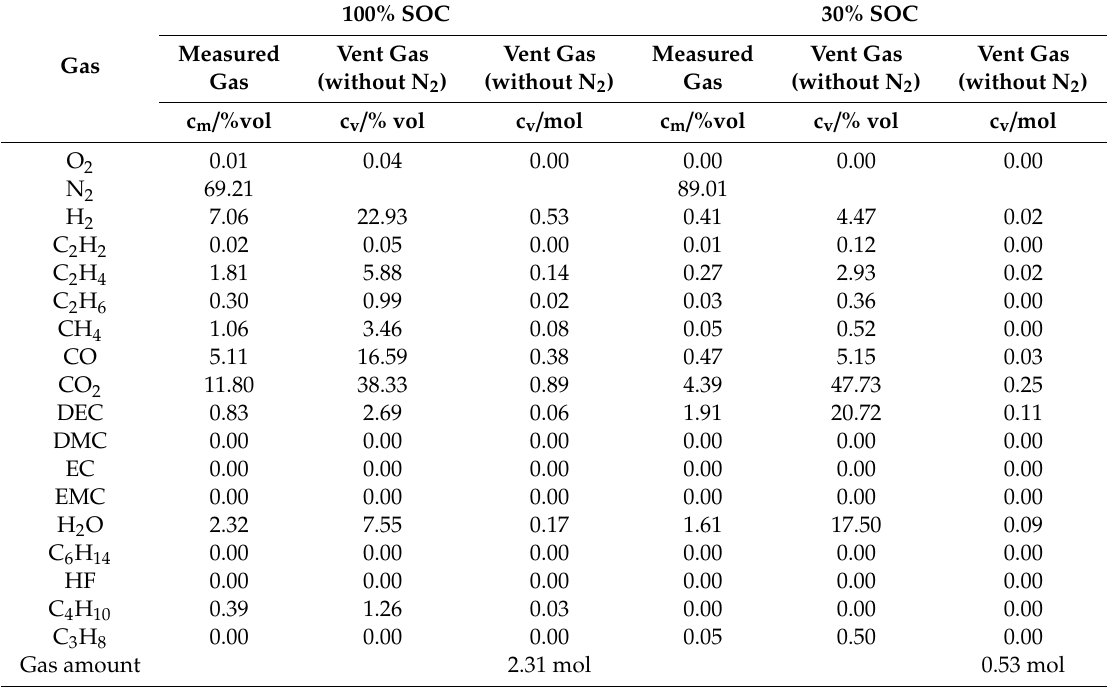
Table 3. Measured gas concentration values at heat triggered fresh automotive pouch cell at 100% SOC versus 30% SOC in N2.